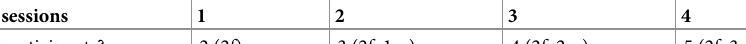
Table 7. Number of participants (#females, #males) taking each number of training sessions.